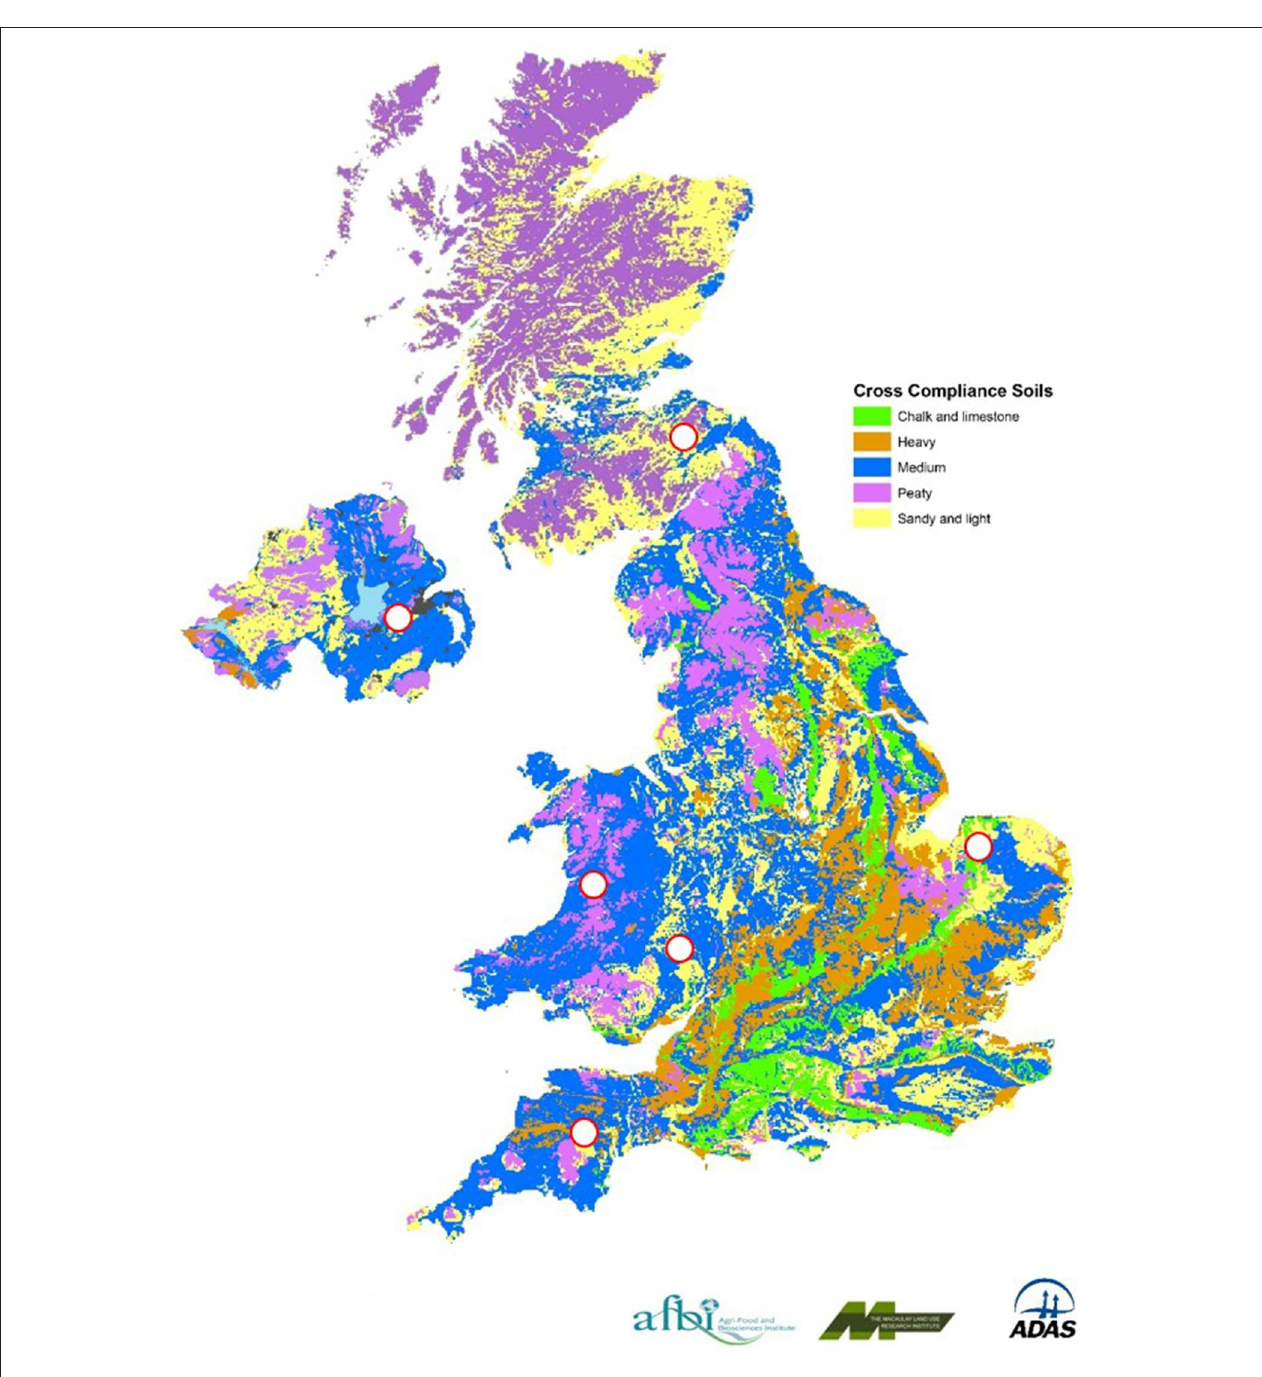
FIGURE 2 | Map showing the locations and soil types of the experimental